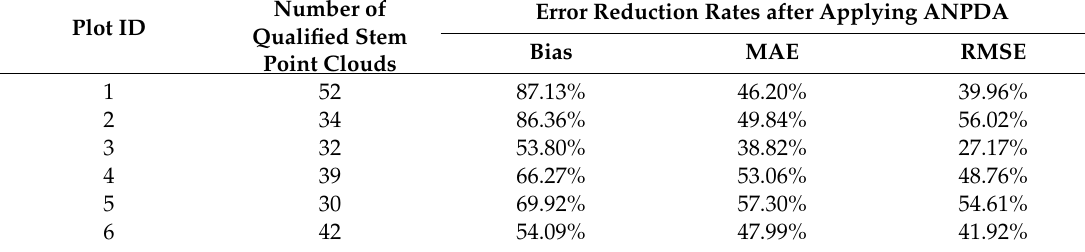
Table 4. Error reduction rates for bias, mean absolute error (MAE), and root mean squared error (RMSE) under di ff erent forest conditions after applying annular neighboring points distribution analysis